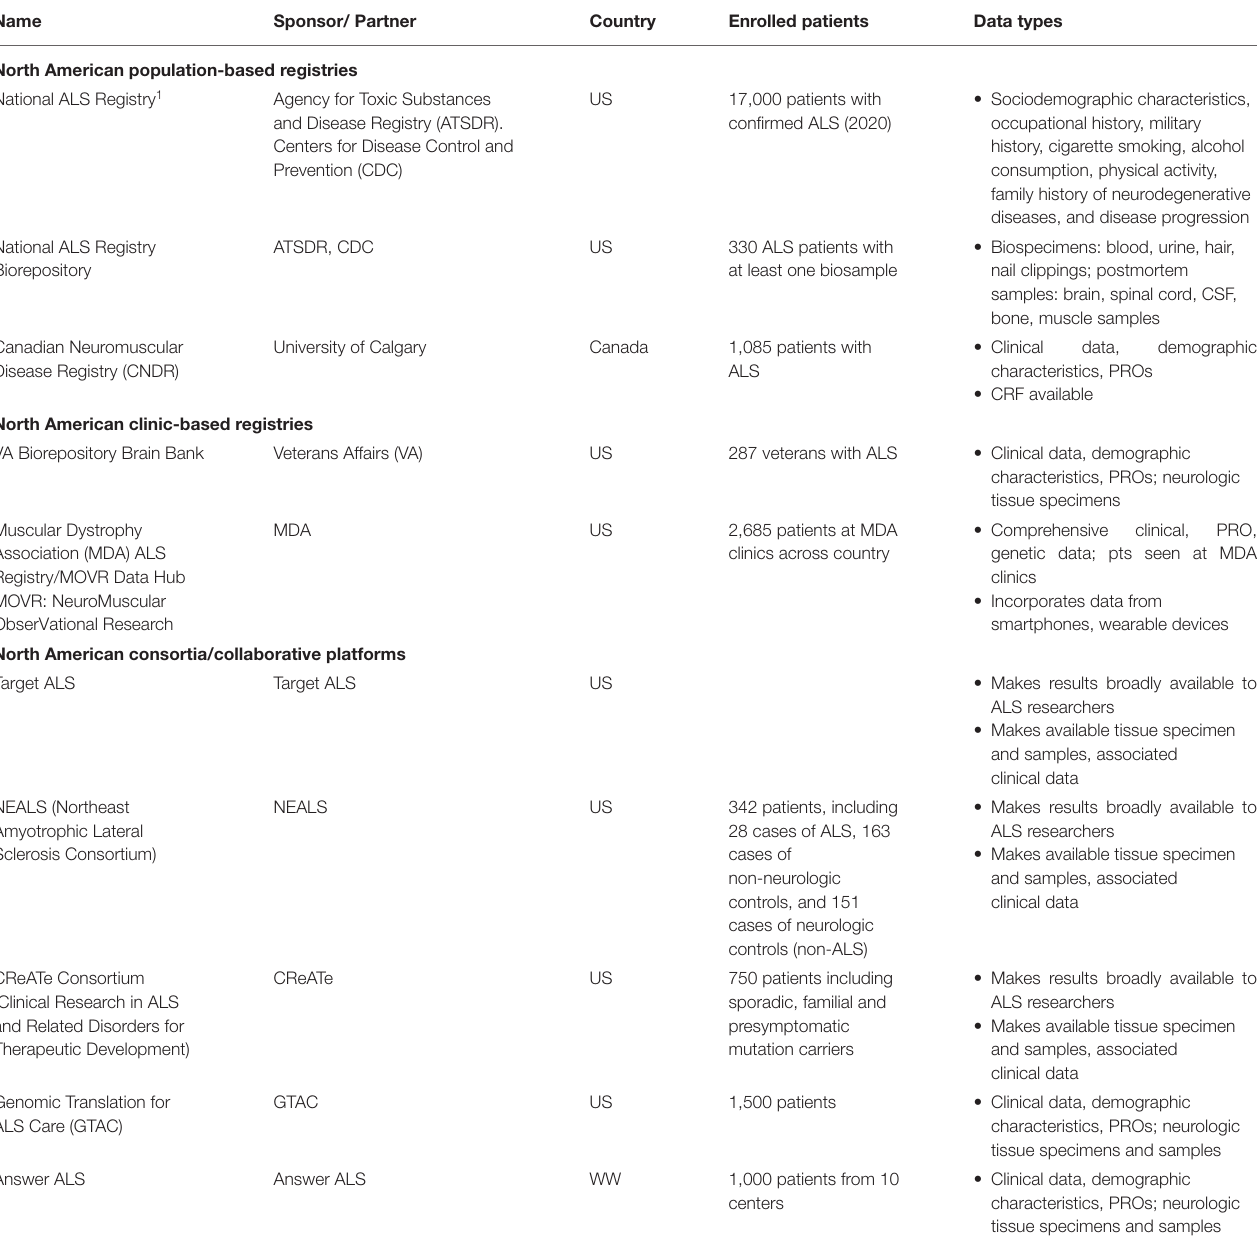
TABLE 1 | Major population-and clinic-based ALS registries and collaborative research platforms in North